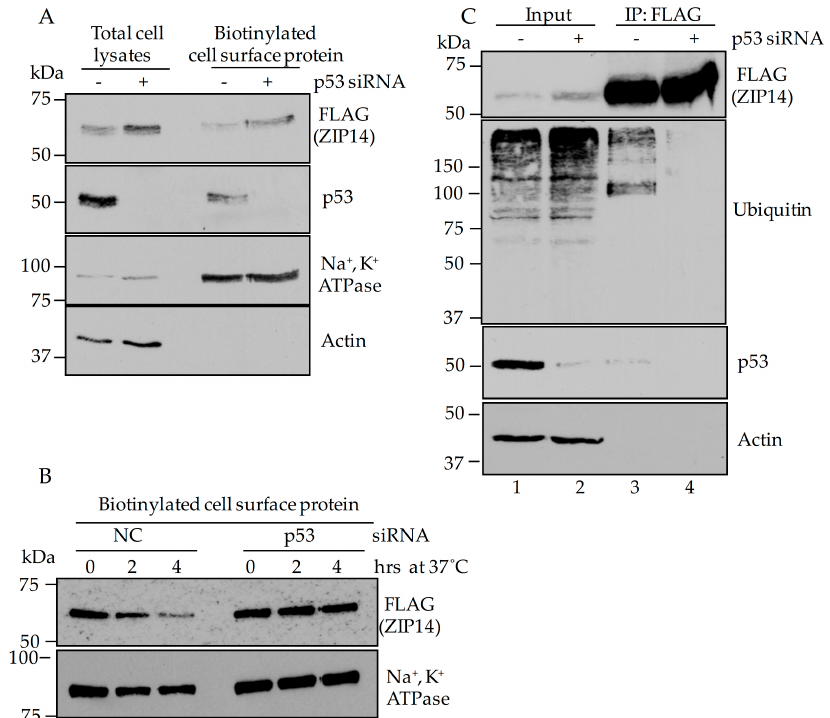
Figure 6. Knockdown of p53 decreases the degradation of cell surface ZIP14. ( A ) HepG2-ZIP14-FLAG cells were incubated with p53-targeting siRNA for 48 h and then cell-surface proteins were labelled with cell membrane-impermeable biotin at 4 ◦ C for 30 min. Total cell lysates were collected and cell-surface proteins were isolated by streptavidin gel. ZIP14 levels in both the total cell lysate and cell-surface fractions were analyzed by immunoblotting; ( B ) cell-surface proteins were labeled with biotin at 4 ◦ C and then chased for 2 and 4 h at 37 ◦ C to allow for endocytosis. Cells were lysed and biotin-labeled cell-surface proteins were isolated by using streptavidin gel and were eluted with 50 mM DTT. Samples were analyzed by immunoblotting. Plasma membrane type Na + , K + ATPase was used as a control for cell-surface protein; ( C ) cells were treated with p53-targeting siRNA for 48 h before the immunoprecipitation procedure. Half of the eluted fraction was probed for ZIP14 and the other half was probed with anti-ubiquitin